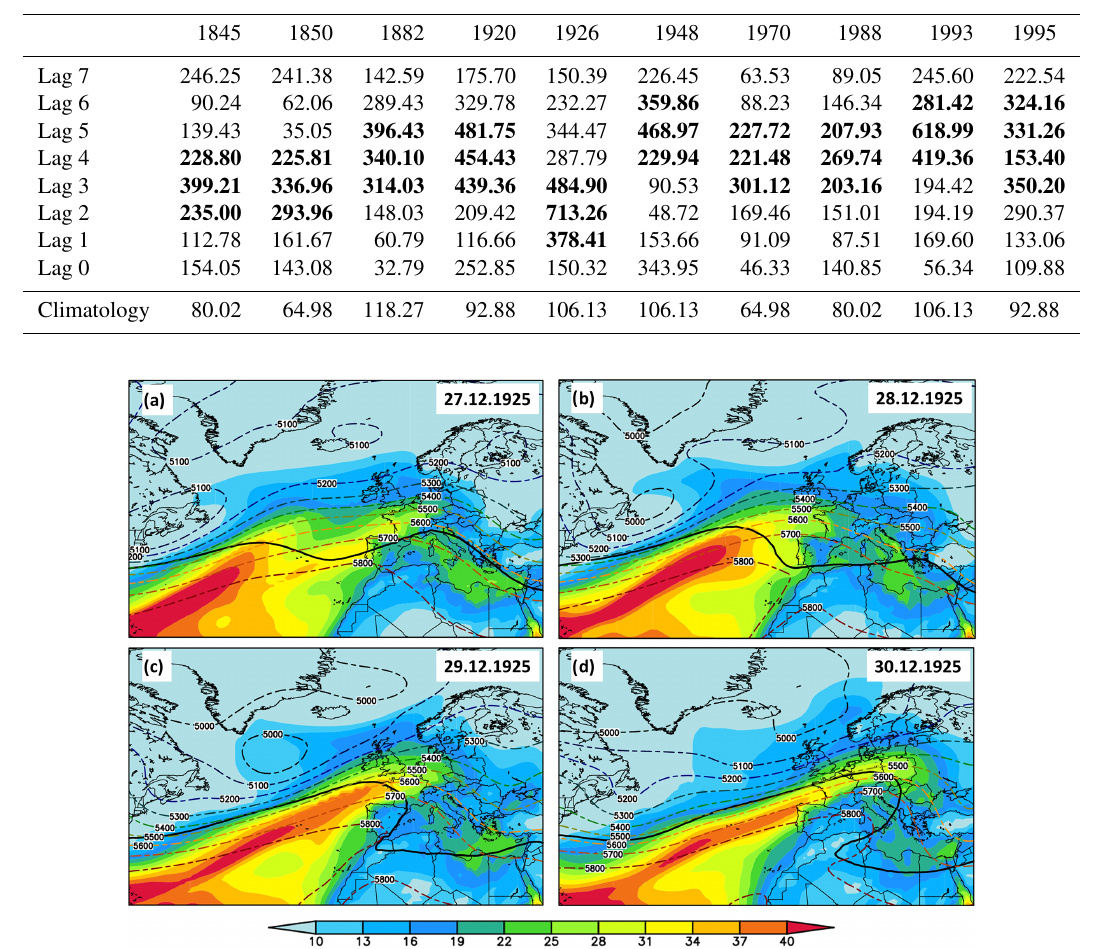
Table 2. Daily values of the magnitude of the IWV for the days prior to each flood peak (see Table 1) averaged over the box (4–12 ◦ E, 47–56 ◦ N). The bold values represent the days on which the highest magnitude was recorded. The climatology was computed over the period 1961–1990.